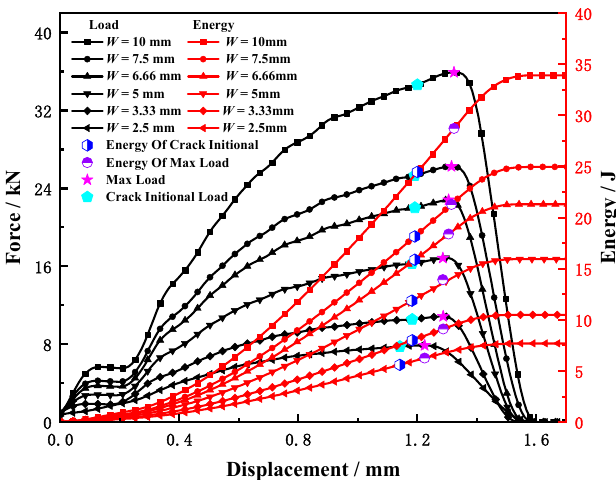
Figure 19. The load–displacement and energy–displacement curves for different widths.